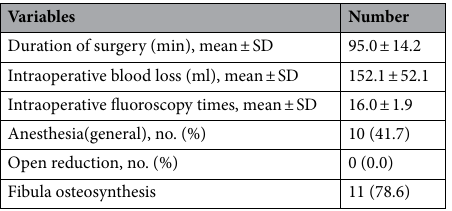
Table 2. Details of surgical data. Abbreviation: SD standard deviation.